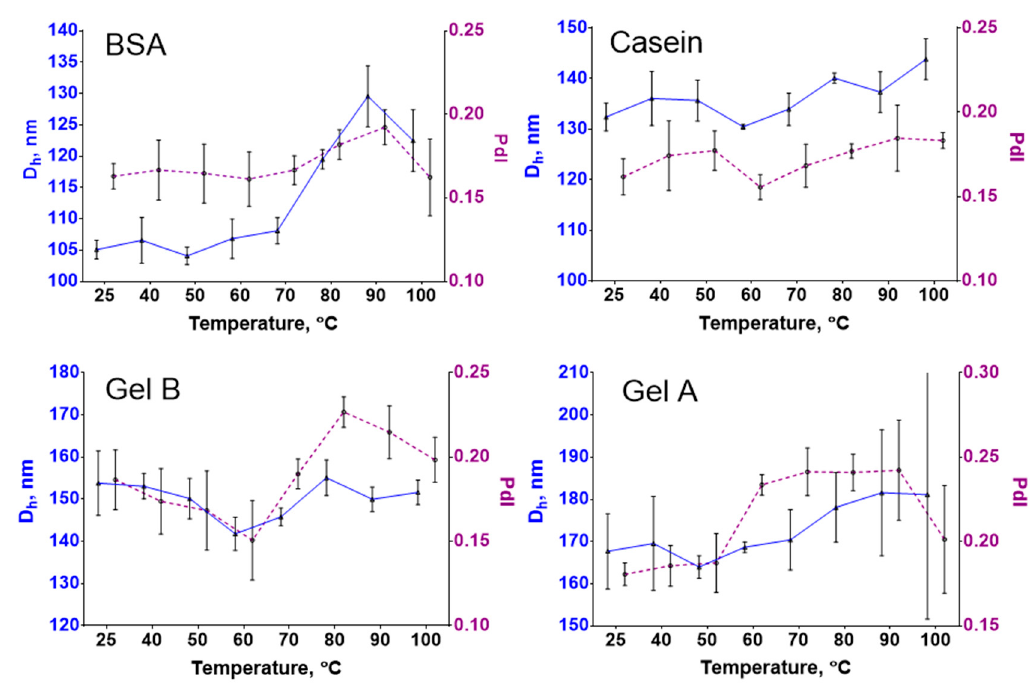
Figure 6. Thermal stability of ( BSA ) Fe@C-NH 2 / BSA / G; ( Casein ) Fe@C-NH 2 / Casein / G; ( Gel B ) Fe@C-NH 2 / Gelatin B / G; ( Gel A ) Fe@C-NH 2 / Gelatin A / G. Solid line—hydrodynamic diameter; dashed line—polydispersity index, n = 3, mean ± SD.